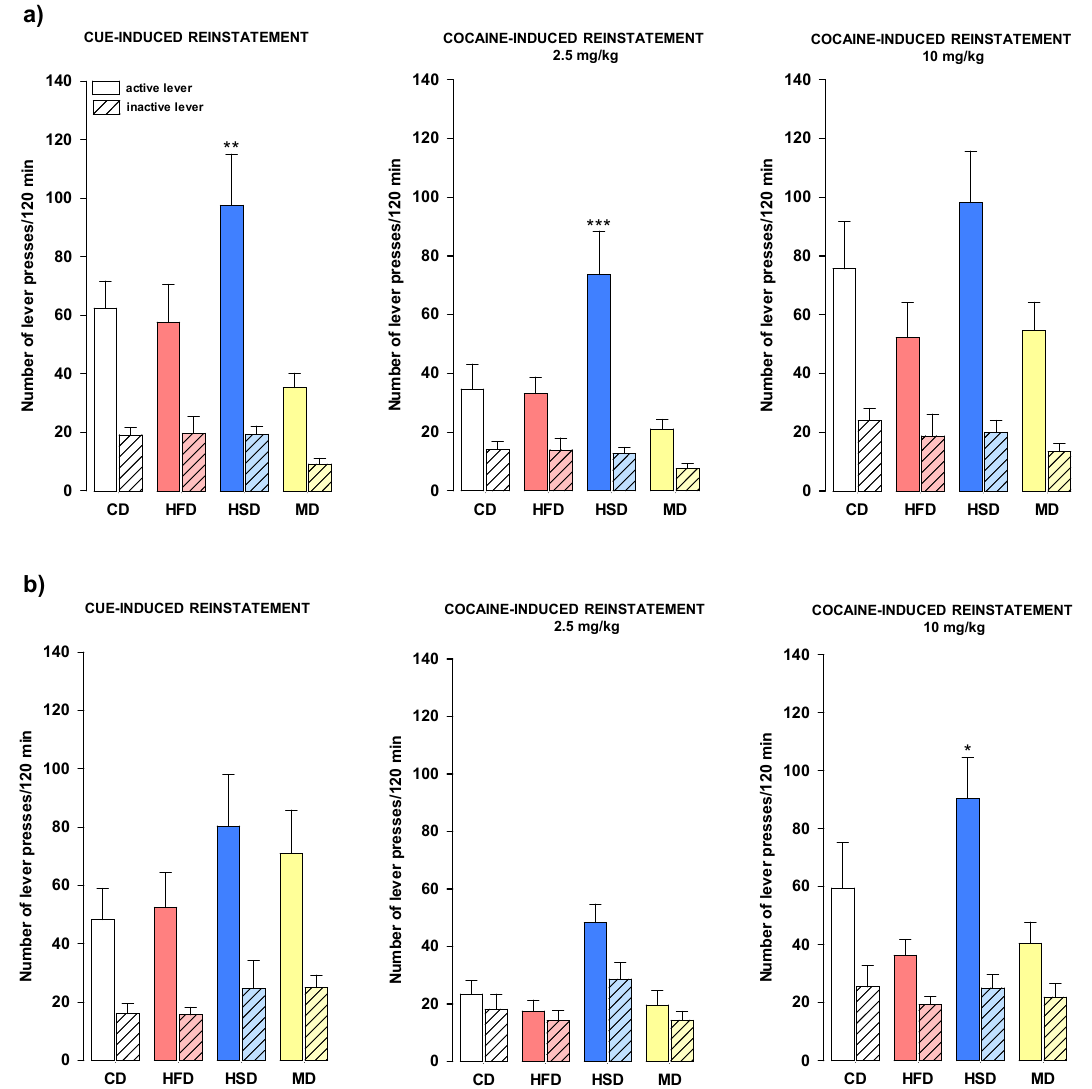
Figure 5. E ff ects of a maternal high-fat (HFD), high-sugar (HSD), or mixed (MD) diet during pregnancy and lactation on reinstatement of the cocaine-seeking behavior induced by the cue (CUE; tone + light) and the drug in female rat o ff spring. Drug-induced reinstatement was triggered by the administration of cocaine (2.5 or 10 mg / kg, i.p.). ( a ) Tests were performed after cocaine (0.5 mg / kg / infusion) self-administration with an increasing schedule of reinforcement (FR1–5) and 10 days of extinction training. ( b ) Tests were performed after cocaine (0.25–1 mg / kg / infusion) self-administration with a stable FR1 schedule of reinforcement and 10 days of extinction training. The numbers of active and inactive lever presses are expressed as the mean ( ± SEM). The number of animals each group was as follows: CD ( n = 11), HFD ( n = 10), HSD ( n = 10), MD ( n = 12). Data were analyzed by two-way ANOVA and the post